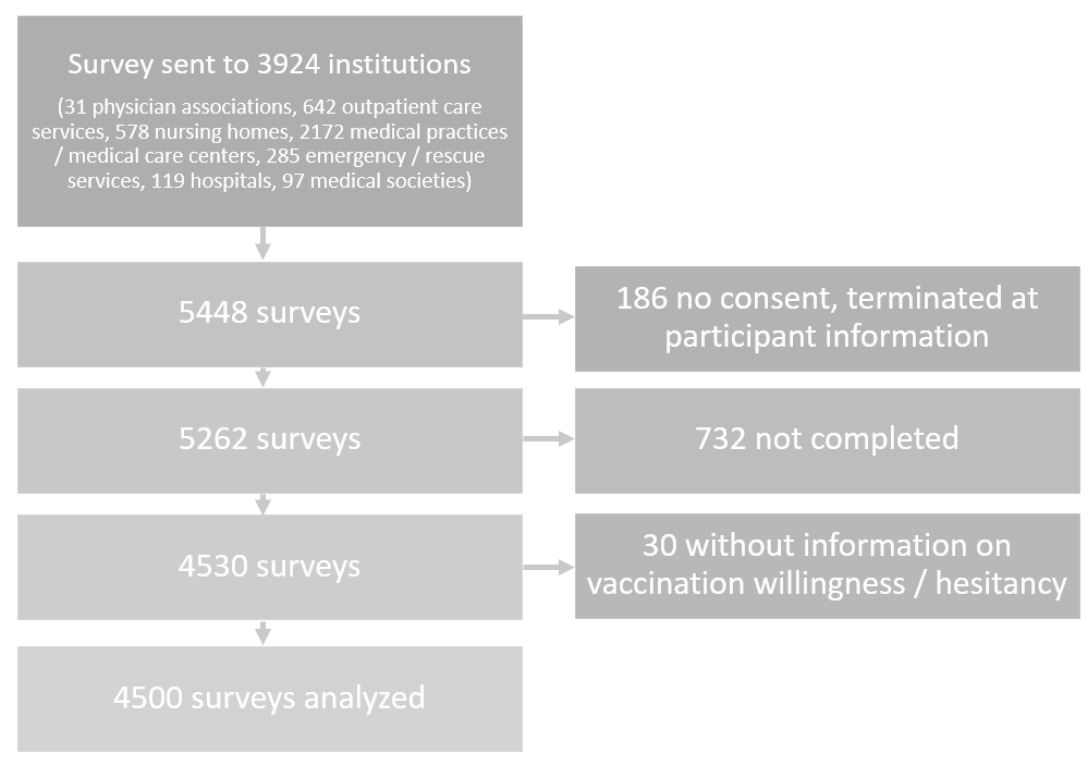
Figure 1. Flow Chart, adapted from Holzmann-Littig et al. [12]. Overall results can be found in Supplementary Table